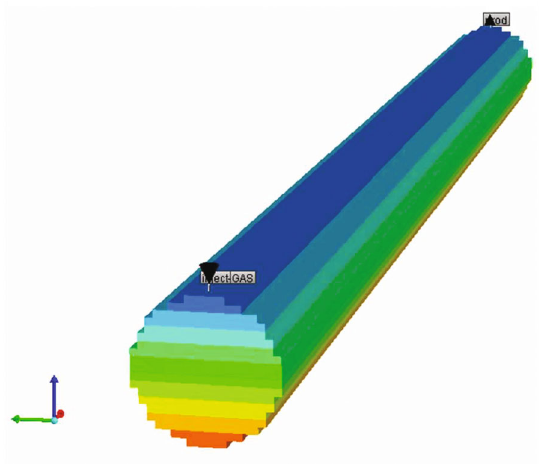
Figure 6: The laboratory-scale model.